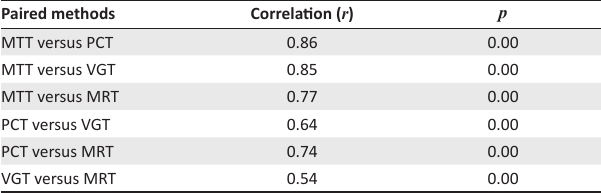
TABLE 3: Correlation analysis for four near horizontal heterophoria methods.